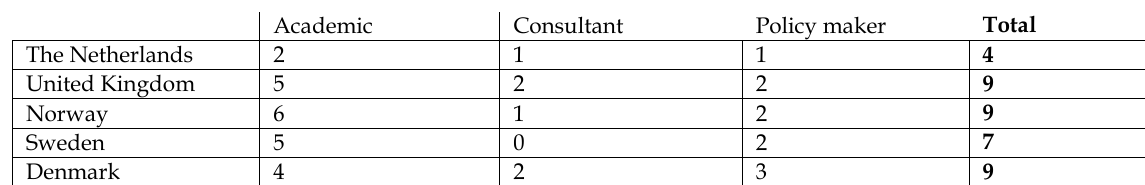
Respondent classified in relation to their profession and country Academic Consultant Policy